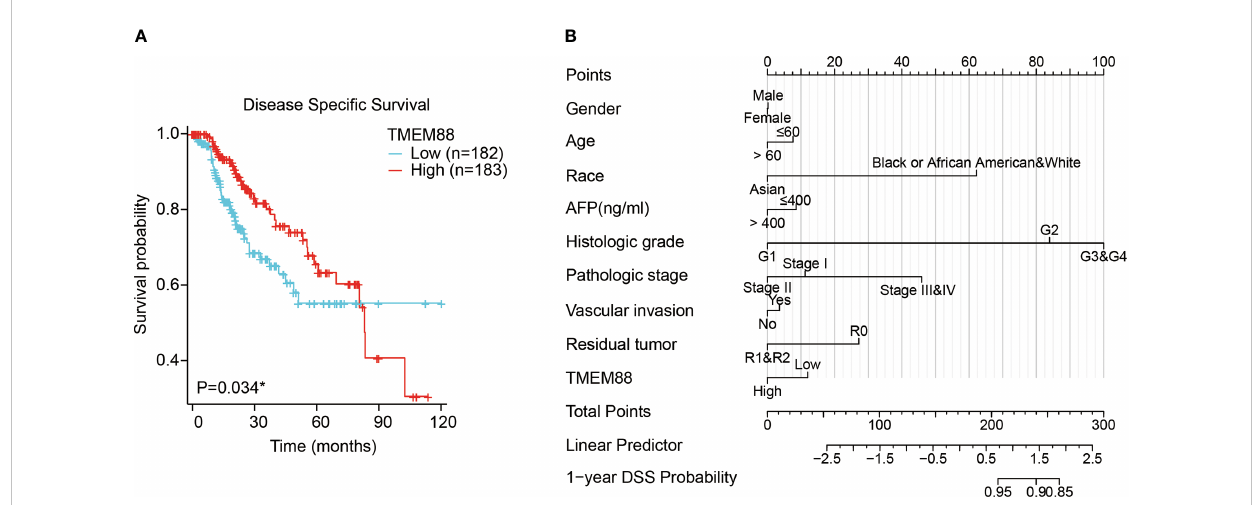
FIGURE 3 Lower TMEM88 predicted worse disease-speci fi c survival of HCC. (A) Kaplan-Meier survival analysis and log-rank test showed that HCC patients with lower TMEM88 mRNA level exhibited worse disease-speci fi c survival. (B) A prognostic predicting nomogram was established according to the